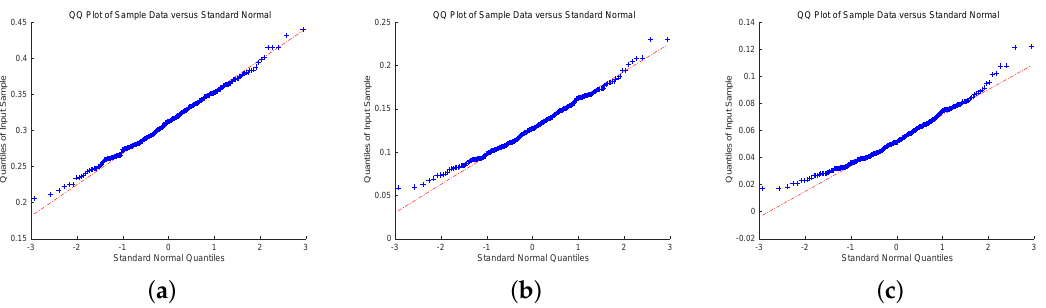
Figure 5. QQ-plot of ED for Combination-of-exponentials claim size density with T = 720: ( a ) u = 1; ( b ) u = 3; ( c ) u = 5.